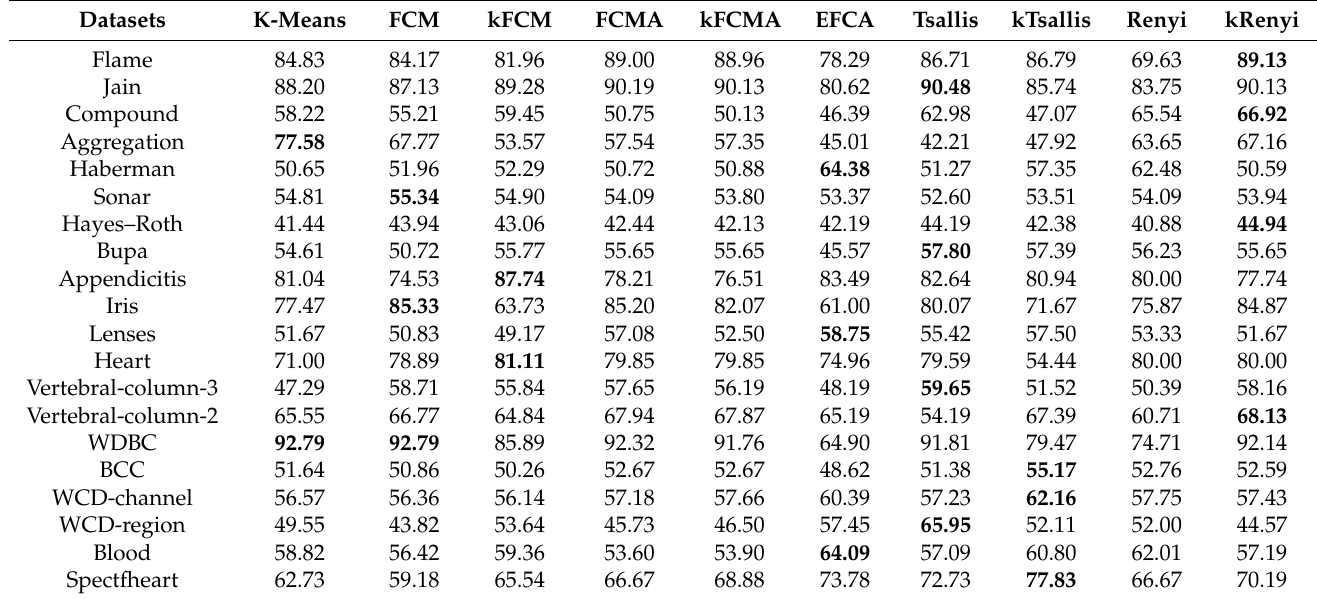
Table 3. Results of the computational study. Table cells present the mean accuracy of the 10 experimental replications attained by each method on each